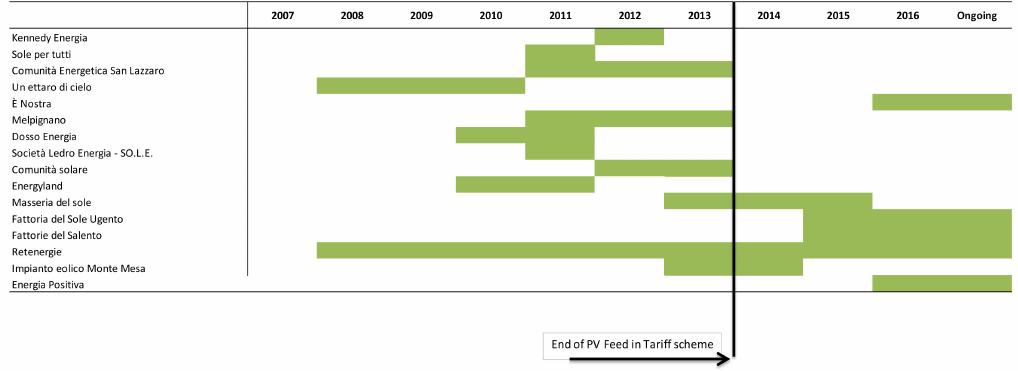
Figure 4. Timing of renewable energy plants development across CE